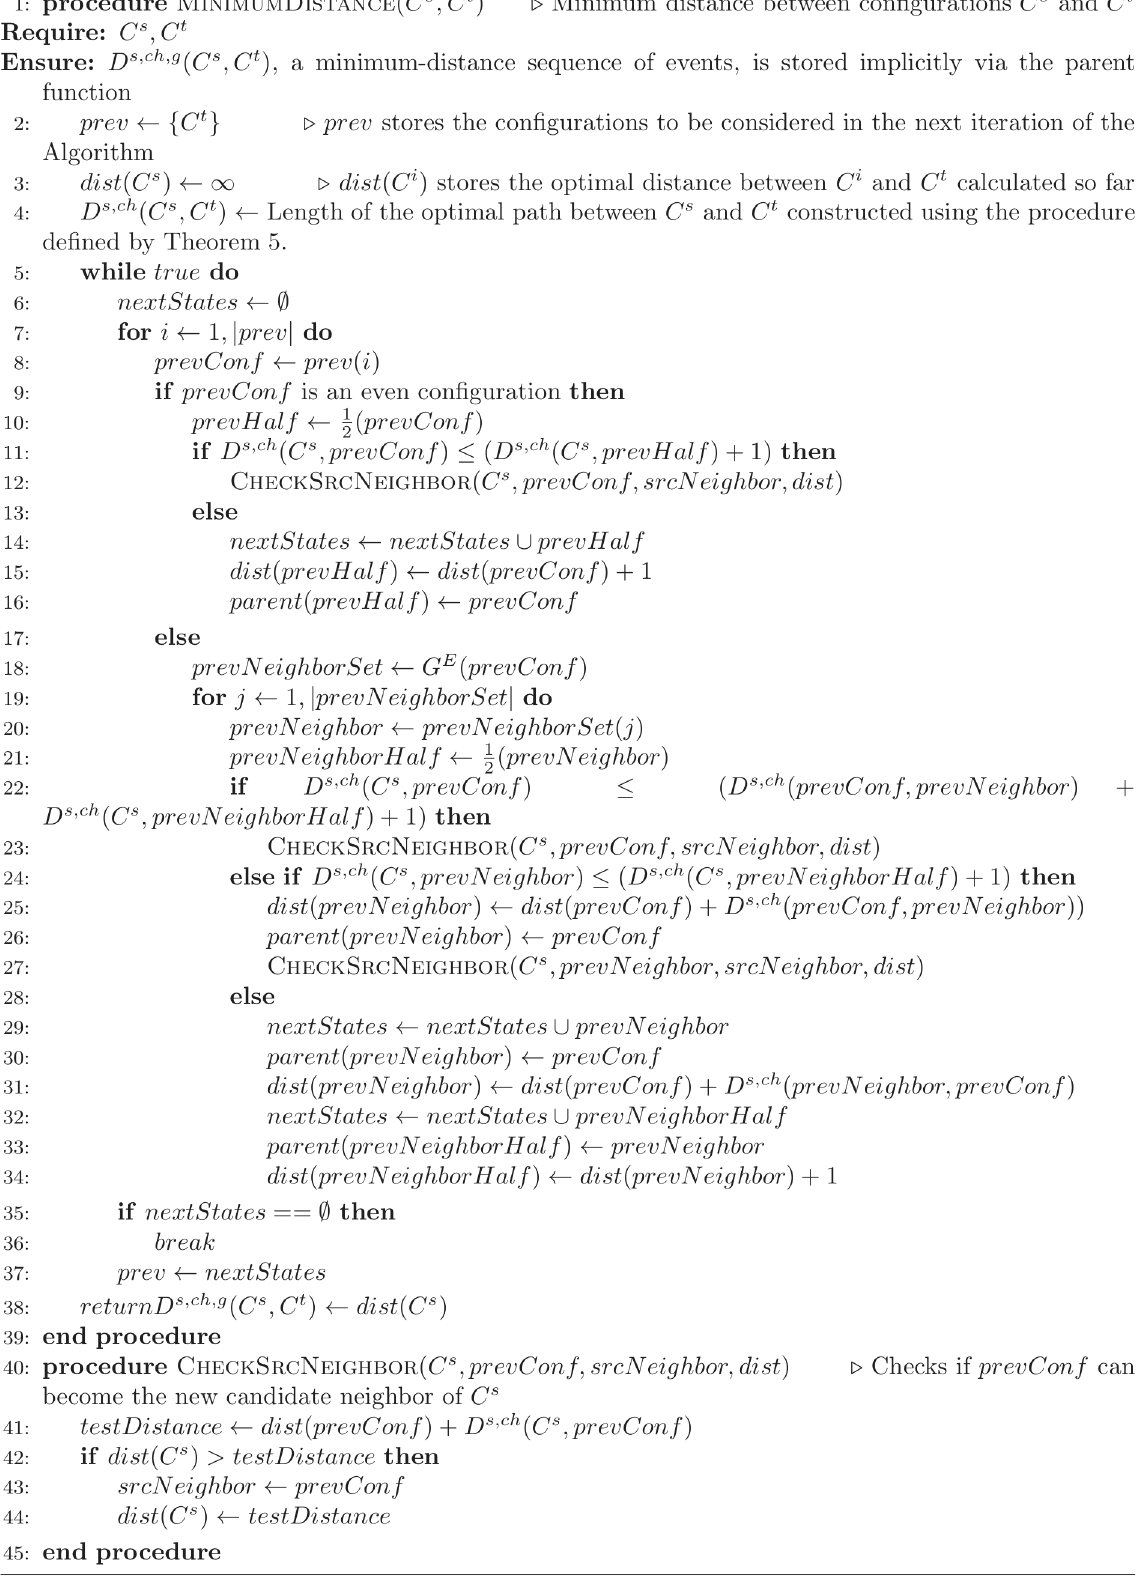
PLOS Computational Biology | www.ploscompbiol.org